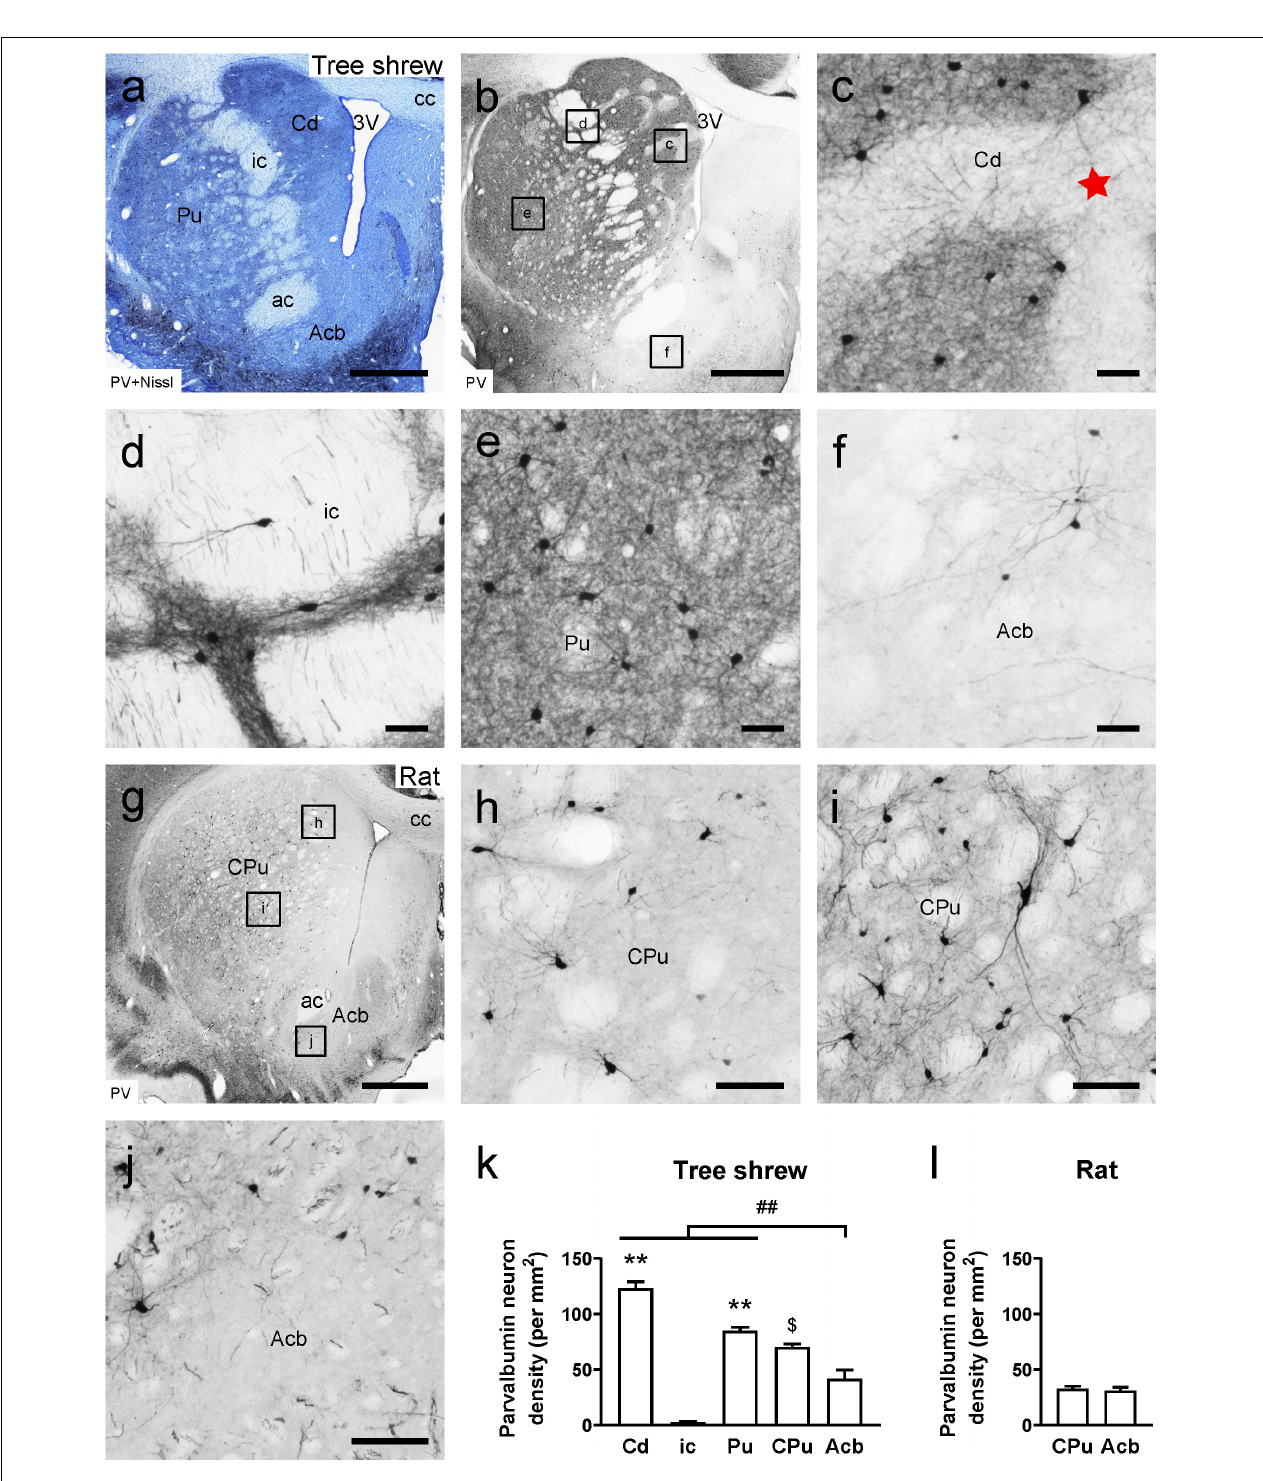
FIGURE 1 | Photomicrographs of parvalbumin (PV)-ir staining are shown in the striatum of the tree shrew and rat brains. (a) Photomicrograph showing Nissl staining (blue) following PV immunoperoxidase labeling (black) in a coronal section of the tree shrew striatum. (b) Low-magnification photomicrograph illustrating PV-ir staining in an adjacent section of the tree shrew striatum. (c–f) High-magnification image of PV immunoreactivity in the caudate nucleus (Cd), internal capsule (ic), putamen (Pu), and accumbens nucleus (Acb) of the tree shrew striatum (boxed area in b). The red star indicates the location of the striosome and matrix compartments in the Cd. (g) Low-magnification photomicrograph illustrating PV-ir staining in an equivalent section of the rat striatum. (h–j) High-magnification photomicrograph illustrating PV immunoreactivity in the caudate putamen (CPu) and Acb of the rat striatum (boxed area in g). (k) Quantitative analysis of the density